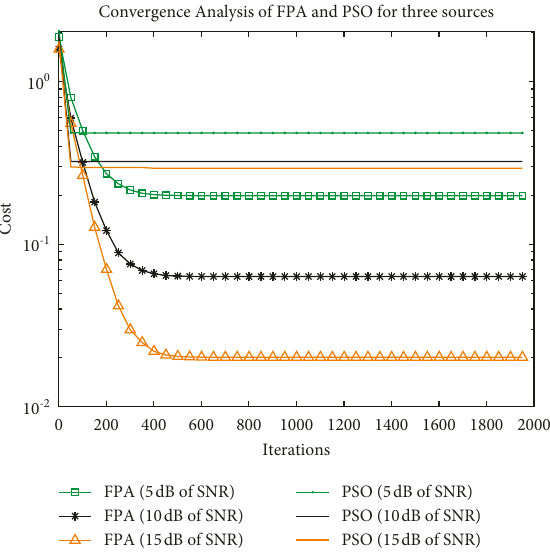
Figure 3: Convergence analysis of FPA for two sources. Figure